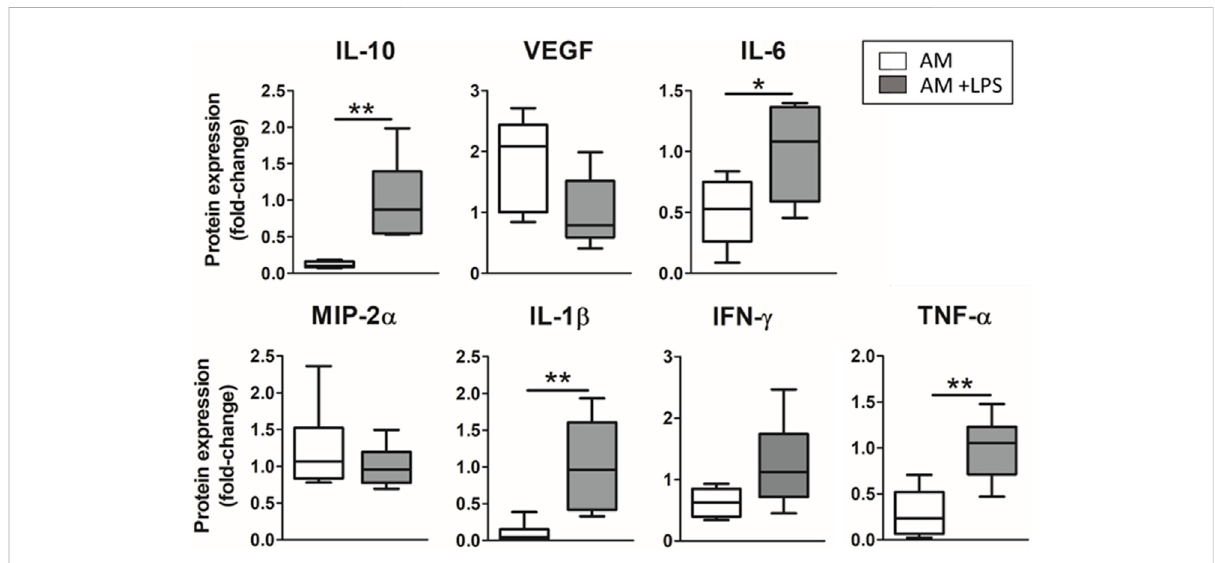
FIGURE 5 Response to LPS endotoxin of the advanced model (3D cultured LMSC in lung hydrogel with ATII cultured on top, subjected to cyclic stretch – Advanced Model).